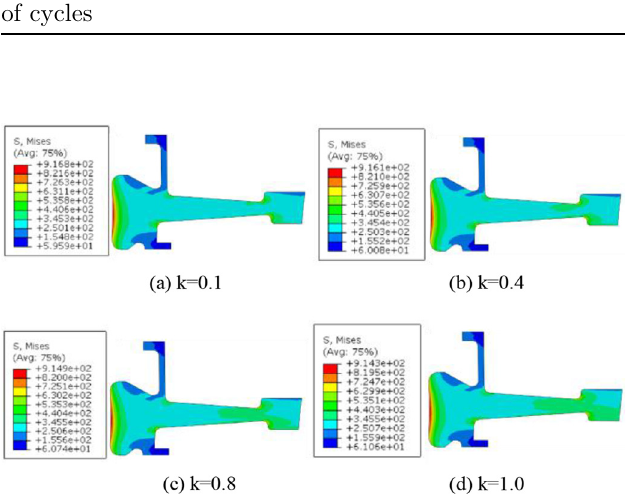
Fig. 15. Turbine disk stress distribution diagram with different values of parameter k: (a) k = 0.1, (b) k = 0.4, (c) k = 0.8, and (d) k =